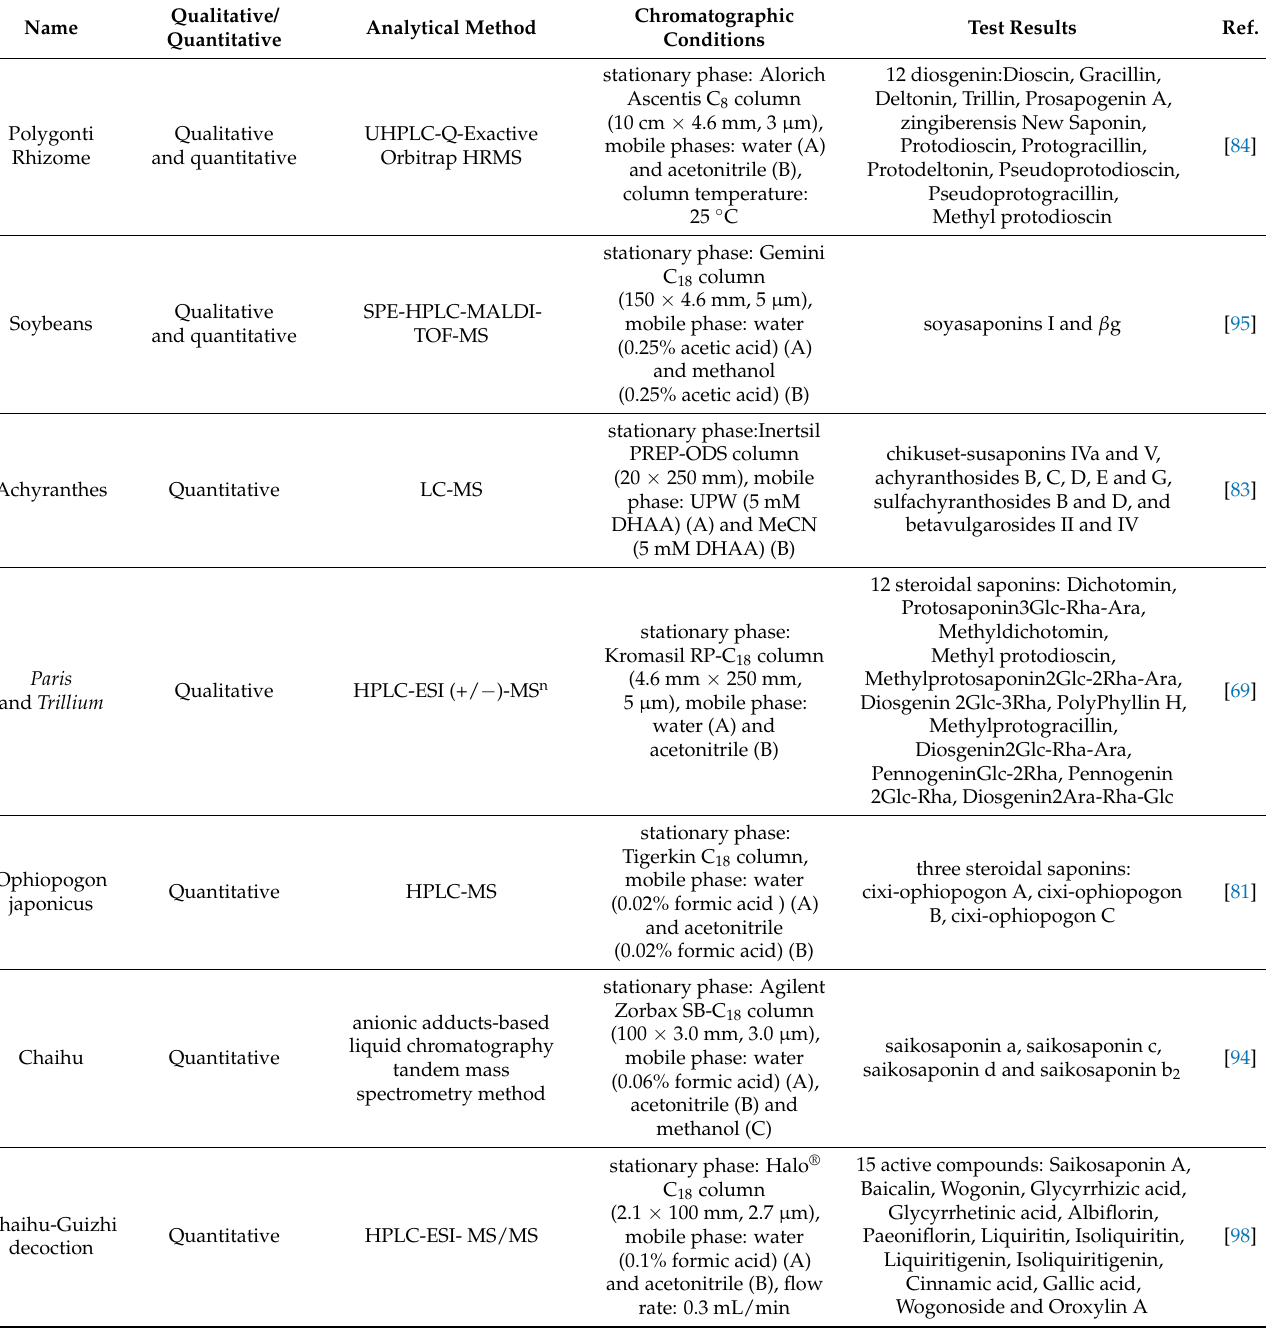
Table 4. Application of high-performance liquid chromatography-mass spectrometry in the determi- nation of medicinal materials and their preparations containing